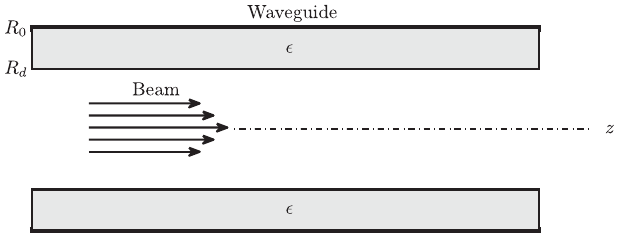
FIG. 1. (Color) Configuration of the Cerenkov